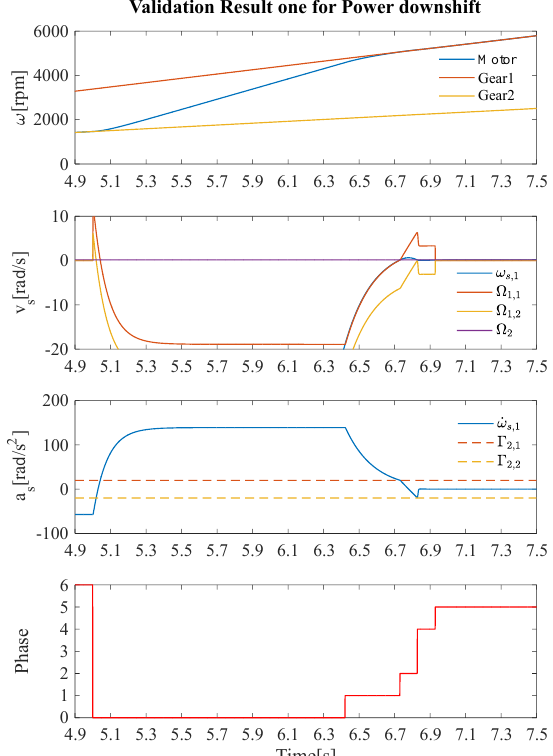
Figure 7. Simulation results illustrating the control strategy and the performance during the down- shifting process.